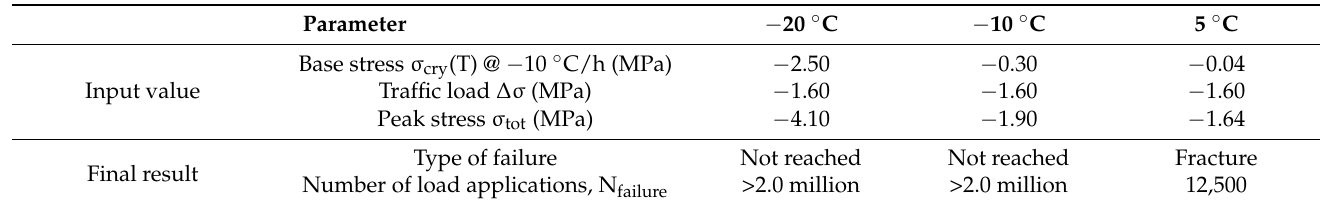
Table 8. Input values and results for the uniaxial cyclic tensile stress test of PMB25